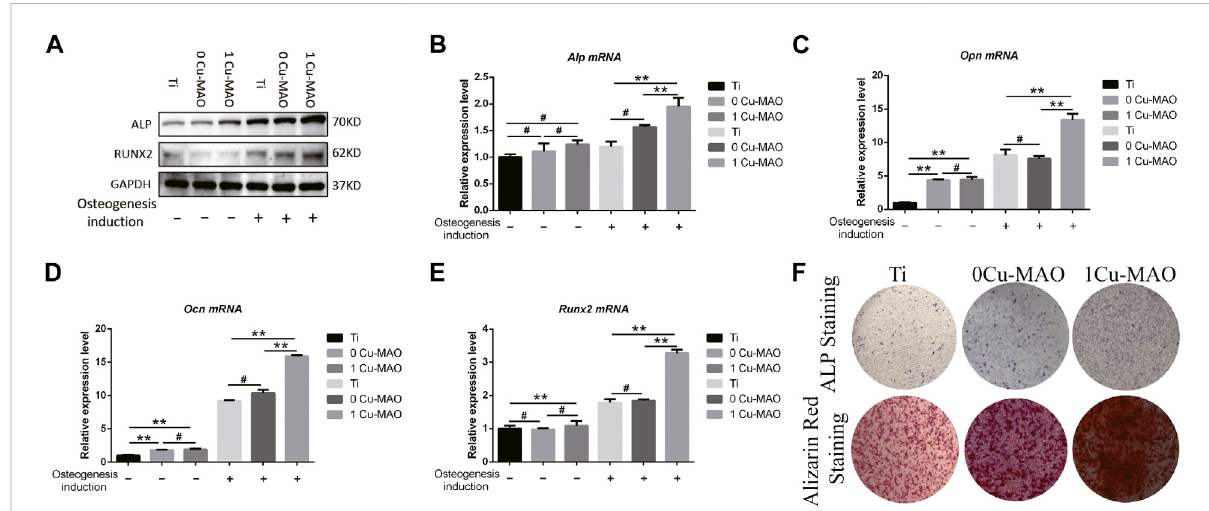
FIGURE 8 TheosteogenicabilityofCu-MAO. (A) Osteogenicrelatedprotein(ALPandRUNX2)expressionlevel. (B – E) OsteogenicrelatedmRNA( Alp , Opn , Ocn ,and Runx2 )expressionlevel. (F) ALPandAlizarinredstainingofdifferentsurfaceatday7andday14,respectively. Dataarepresented asmean± SD; (* p < 0.05, vs. Ti